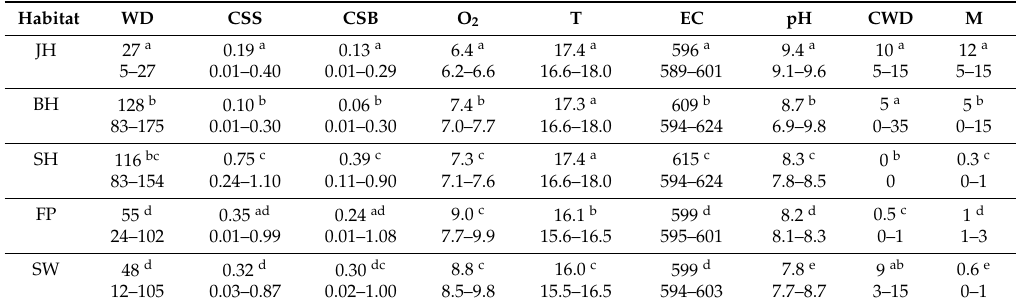
Table 1. Abiotic habitat variables measured at the five assessed habitat types: WD = water depth, CSS = current speed measured 5 cm below the water surface (ms − 1 ), CSB = current speed measured 5 cm above the river bottom (ms − 1 ), O 2 = dissolved oxygen concentration (mgl − 1 ), T = Water temperature in the free flow ( ◦ C), EC = electric conductance ( µ Scm − 1 ), pH = pH-value, M = coverage of macrophytes (%), CWD = coarse woody debris coverage (%), CG = coarse gravel introduced with grain size. Upper layer = mean value, lower layer = minimum to maximum values. JH, BH, SH, SW, and FP refer to